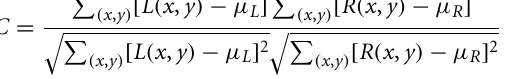
FIGURE 1 | Illustration of the general structure of the stimulus, and the manipulation of luminance and orientation ambiguity. (A) The stimulus is built from tiles of filtered random dot textures, a and b . In one eye, these are arranged in a repeating ab sequence. In the other eye, they are arranged in a repeating ba sequence. With no difference in luminance or orientation, these stimuli can equally be matched with a crossed or uncrossed disparity (B) With the addition of a difference in luminance between pairs of ab units in each stimulus, matching can be biased toward a particular disparity. (C) Similarity in orientation between